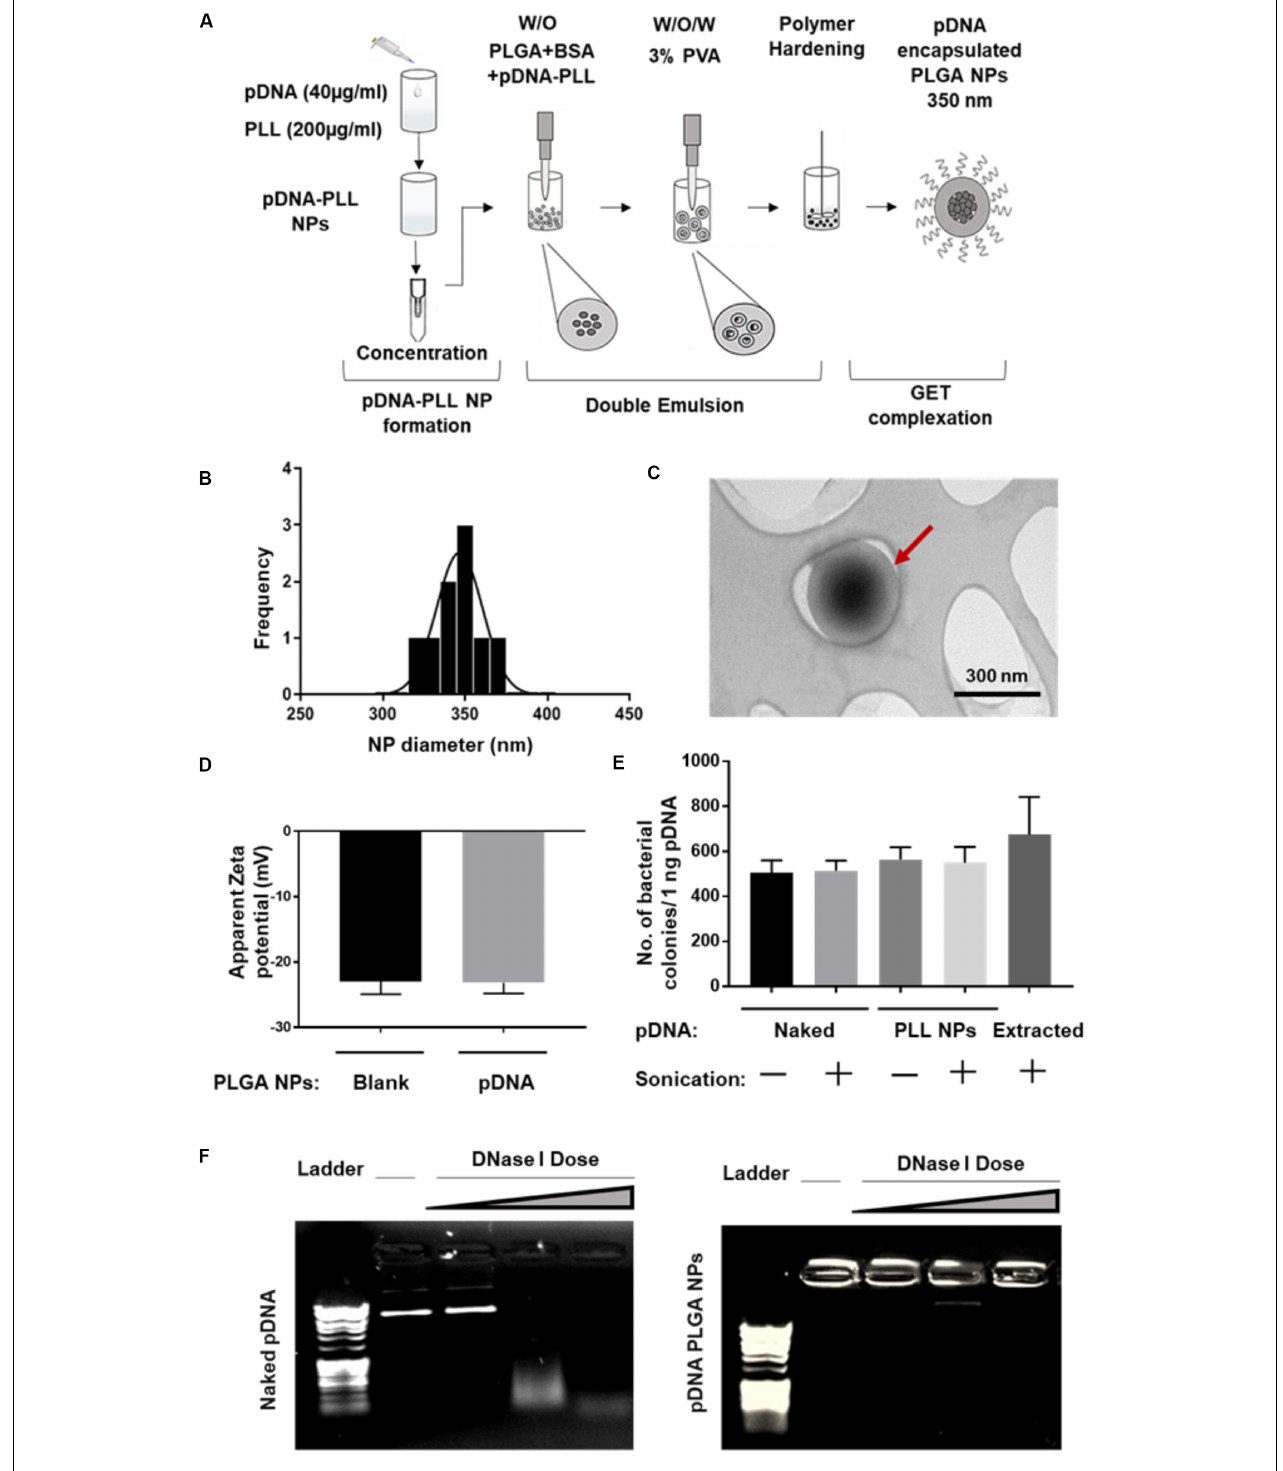
FIGURE 2 | Characterization of pDNA-encapsulated PLGA NPs. (A) A simplified illustration of the process of pDNA encapsulated PLGA NP preparation and GET peptide complexation. (B) Representative PLGA NP size for both blank and pDNA encapsulated, shows homogenous population of the NPs measured by Zetasizer. (C) TEM micrograph of these NPs which confirms the size measured by Zetasizer and demonstrates the spherical, smooth surface of the NPs. Red arrow highlights individual NP. (D) The negative surface charge of pDNA-encapsulated PLGA NPs is comparable to blank NPs and excludes the possibility of PLGA NPs surface contamination with positively charged pDNA-PLL NPs. (E,F) Demonstrates the integrity of the encapsulated pDNA during the preparation process or the enzymatic treatment with DNase I respectively. Doses of DNase I tested were: 0.025, 0.0025, and 0.00025 U/ µ l with 15 min incubation time at 37 ◦ C.